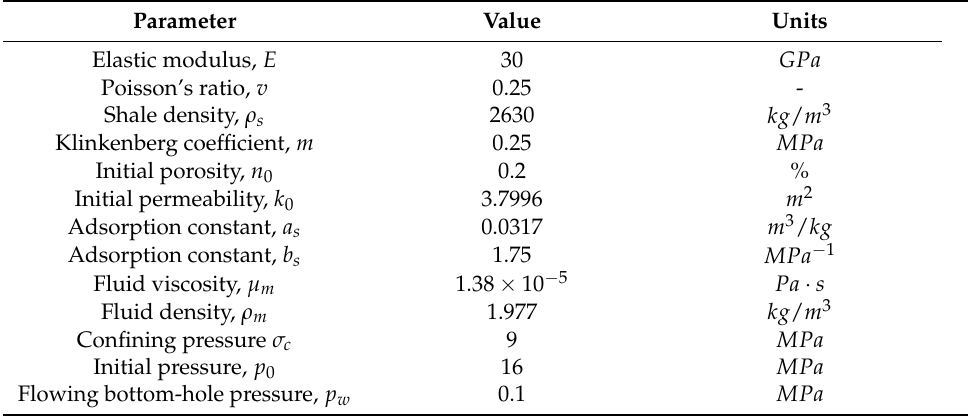
Table 2. Numerical simulation